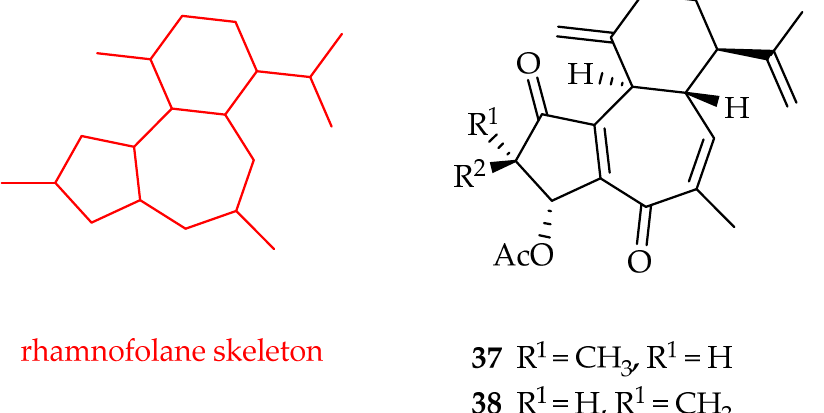
Figure 16. Structures of rhamnofolane skeleton, jatromultone C 37 [23], and jatromultone D 38 [23].